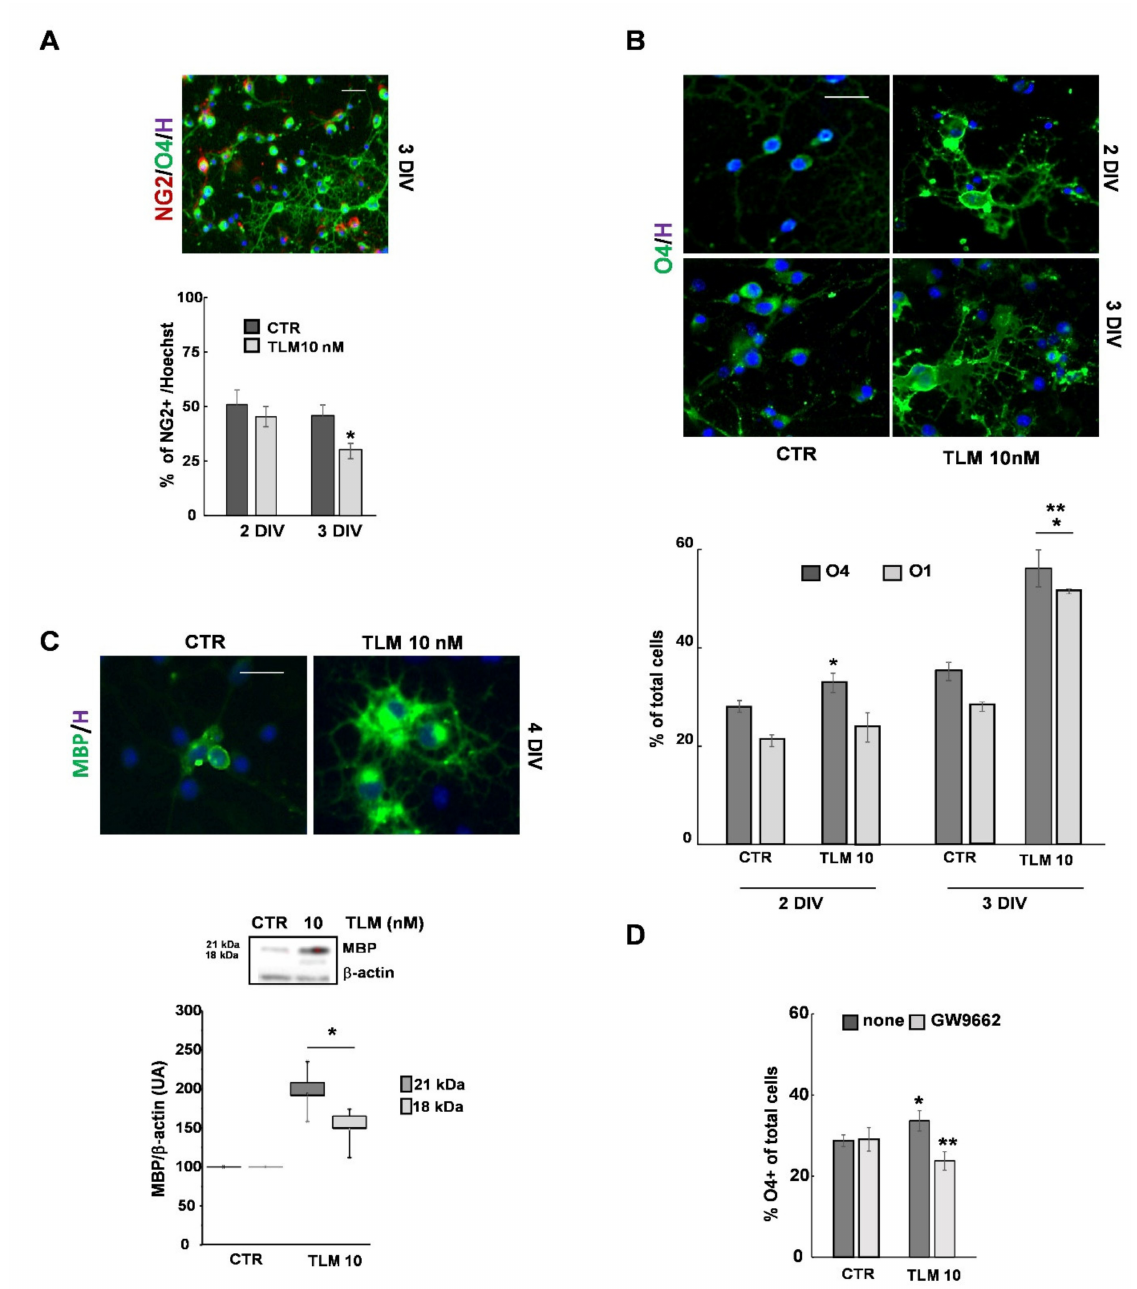
Figure 3. TLM promotes OP differentiation by a PPAR- γ mediated mechanism. At 1DIV, OPs were treated with 10 nM TLM for 24 or 48 h. The cells were processed for IF, and the expression of NG 2 , O 4 and O 1 was evaluated. Data are expressed as a percentage of positive cells to the marker with respect to the total cell number, highlighted by the nuclear dye Hoechst 33258. The photomicrograph in ( A ) shows examples of the morphology of cells at 3DIV, labelled with NG 2 (red), O 4 (green) and Hoechst (blue). Scale bar = 40 µ m. The number of NG2 positive cells is evaluated in 3 independent experiments (* p < 0.001 vs. CTR, unpaired two-tailed Student t -test) in the graph below. The photomicrograph in ( B ) displays examples of the morphology of cells labelled with O 4 (green) in control or TLM-treated cultures. The percentage of O 4 and O 1 positive cells are shown in the graph in ( B ). Data are presented as the Means ± SEM of 10 independent experiments (* p < 0.001 vs. CTR on the same experimental day, ** p < 0.05 vs. 2DIV, unpaired two-tailed Student t -test). ( C ) MBP expression was studied at 4DIV by IF and WB in OP cultures treated with TLM for 72 h. The anti-MBP antibody recognizes the two isoforms (18 and 21 kDa) of the protein in the WB assay. Data are the Means ± SEM of 3–4 independent experiments (* p < 0.001 vs. CTR, unpaired two-tailed Student t -test). Scale bar = 20 µ m. ( D ) The percentage of O 4 + cells is evaluated in the presence or absence of GW9662. Means ± SEM ( n = 3–5; * p < 0.001 vs. CTR, ** p < 0.05 vs. TLM, unpaired two-tailed Student t